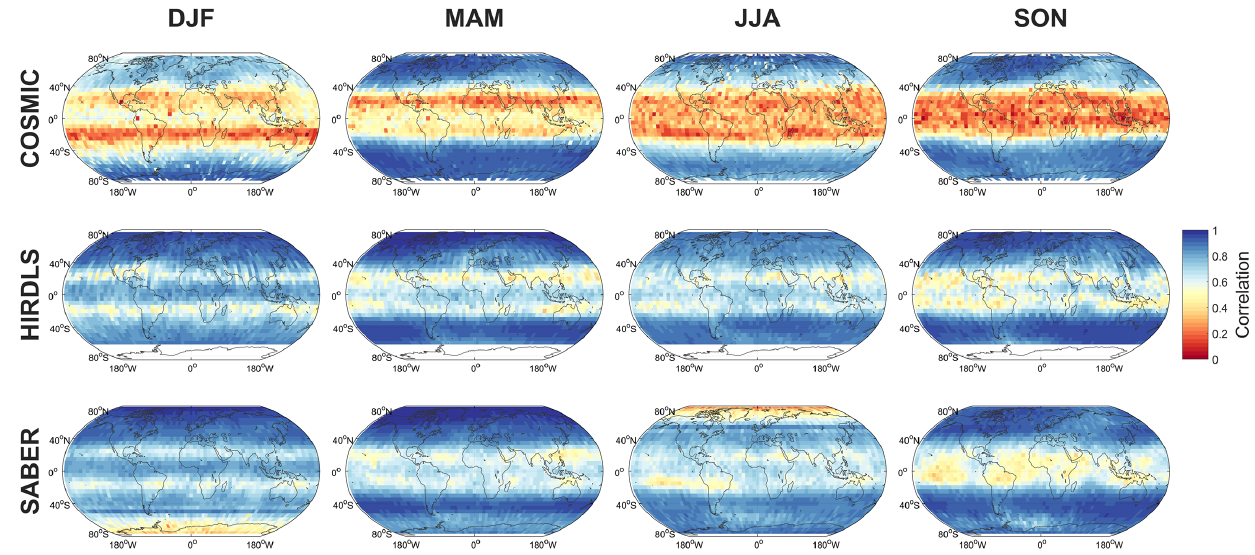
Figure 13. Maps at the 50km altitude level of the correlation between MRM sampled temperatures and each instrument.